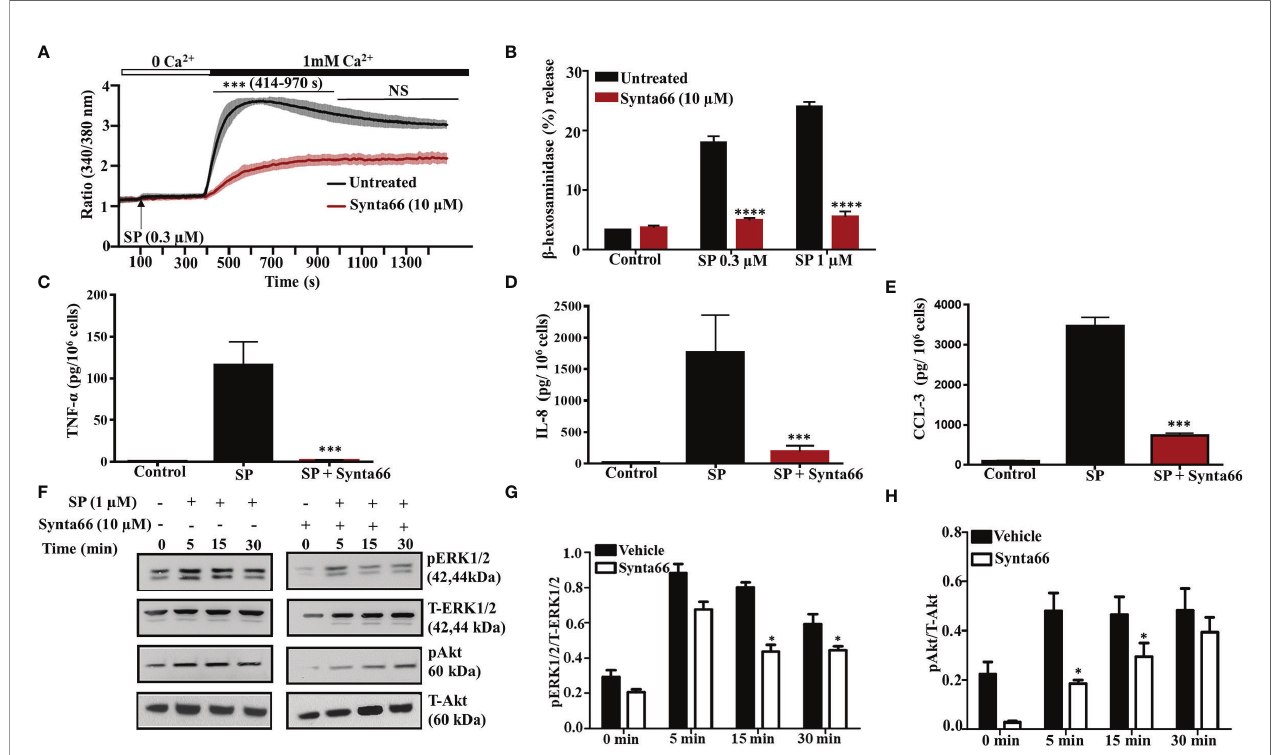
FIGURE 3 | Synta66 Causes Substantial Inhibition of SP-Induced Responses in LAD2 Cells. (A) Fura-2AM-loaded LAD2 cells were preincubated with Synta66 (10 µM, 30 min) in Ca 2+ -free buffer and the measurement of intracellular Ca 2+ mobilization was initiated via the addition of SP (0.3 µM) at 100 s. After 400 s, Ca 2+ concentration of the buffer was increased to 1 mM and Ca 2+ measurement was continued for additional 18 min (B) LAD2 cells were preincubated with Synta66 (10 µM, 5 min), stimulated with the indicated concentrations of SP and b -hexosaminidase release was determined. (C – E) Cells were preincubated with Synta66 (10 µM, 30 min) and stimulated with SP (1 µM for 24 h) and culture supernatants were used to measure TNF- a , IL-8 and CCL-3. (F) Synta66-preincubated cells were stimulated with SP for different time points and western blotting was performed on cell lysate with anti-pERK1/2, anti-pAkt, total anti-ERK1/2 and total anti-Akt antibodies. (G, H) Bar graphs represent relative intensities of bands of phosphoproteins normalized to respective total proteins. Data presented are mean ± SEM of N = 3 experiments. Statistical signi fi cance comparing multiple groups was determined by one-way ANOVA with Tukey ’ s multiple comparisons at a value ****p <0.0001, ***p <0.001, and NS, “ not signi fi cant ” (A – E) . Statistical signi fi cance was determined by Student ’ s t-test at a value *p < 0.05 (G, H)